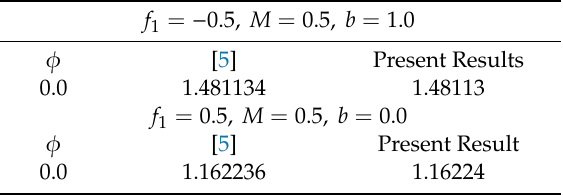
Table 1. Reliability of the presented analysis (numerical values for skin friction coe ffi